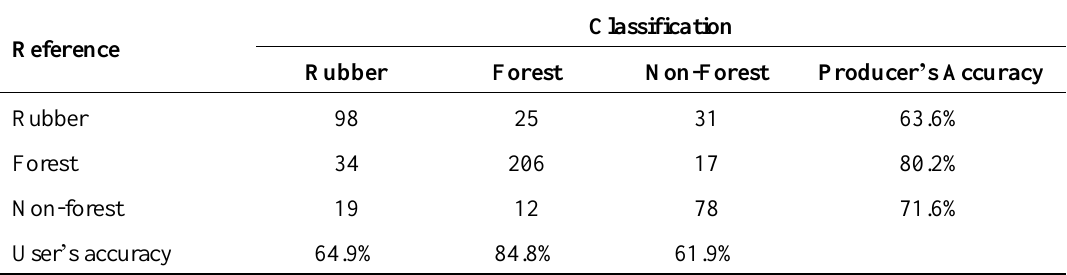
Table 3. Confusion matrix for the overall best model based on Enhanced Vegetation Index (EVI) and short-wave infrared (SWIR)